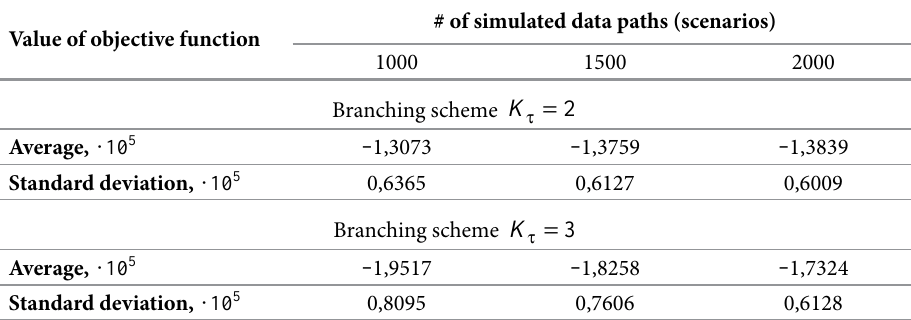
Table 7. In-sample stability test for the instance with Gaussian dependency structure and catastrophe losses # of simulated data paths Value of objective function